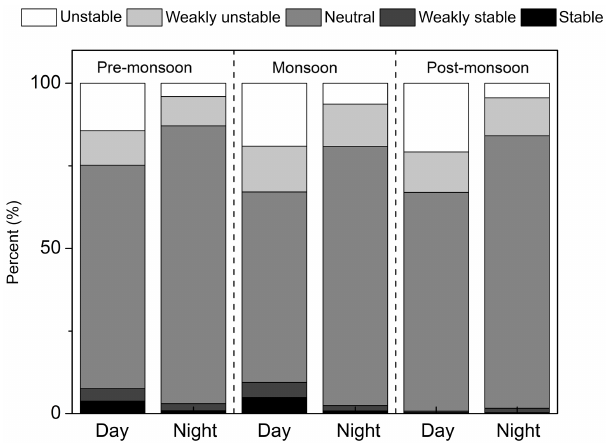
Figure 6. Frequency percent of stability classes in day (when the shortwave radiation is > 20Wm − 2 ) and night (when the short- wave radiation is ≤ 20Wm − 2 ) during pre-monsoon, monsoon and post-monsoon periods from 2012 to 2015. The stable classes are defined as atmosphere stability ( ζ = z/L , where z is the measure- ment height and L is the Monin-Obukhov length): stable ( ζ > 0 . 1), weakly stable (0 . 05 < ζ < 0 . 1), near neutral ( − 0 . 05 < ζ < 0 . 05), weakly unstable ( − 0 . 1 < ζ < 0 . 05) and unstable ( ζ < − 0 . 1).